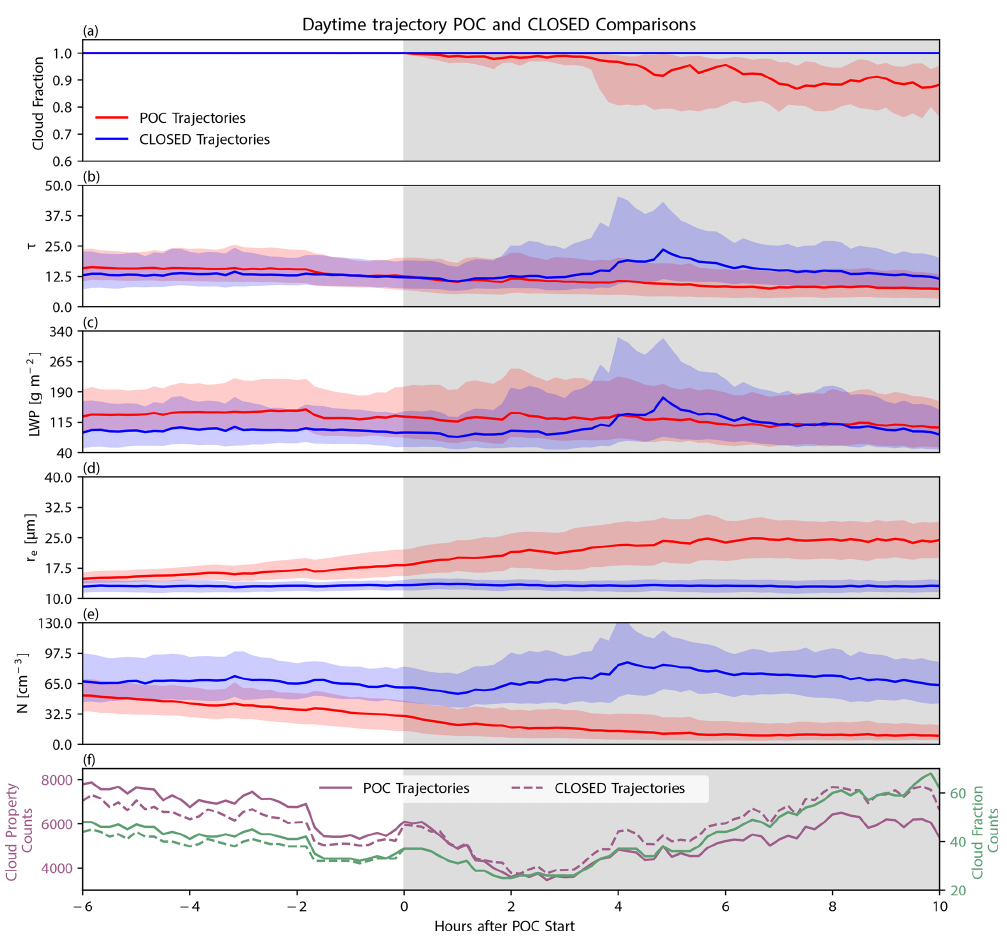
Figure 13. The median changes in daytime cloud fraction (a) , cloud optical depth (b) , liquid water path (c) , effective radius (d) , and cloud drop number concentration (e) for the 6h before until 10h after POC development are shown along all pocket of open-cell stratocumulus (POC shown in red) and comparison (CLOSED shown in blue) trajectories, where the red and blue fill represent changes in the interquartile range. The number of valid samples for both the GOES-16 microphysical properties (purple) and GOES-16 cloud fraction (green) are shown in (f) . Gray shading indicates the time after POC